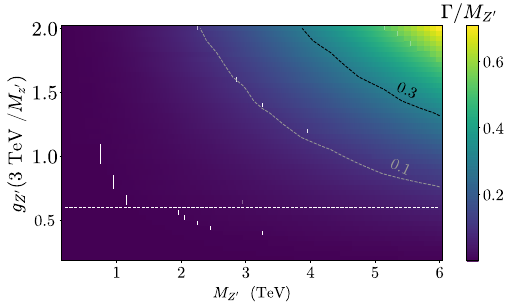
Fig. 5 Thewidth-to-massratio, (cid:10)/ M Z (cid:2) oftheTFHM Z (cid:2) bosonoverthe scannedparameterspace.Thecontours (cid:10)/ M Z (cid:2) = 0 . 1and (cid:10)/ M Z (cid:2) = 0 . 3 are shown by the dashed grey and black lines respectively. The region favoured by the flavour and electro-weak data falls between the dashed white line and the bottom of the